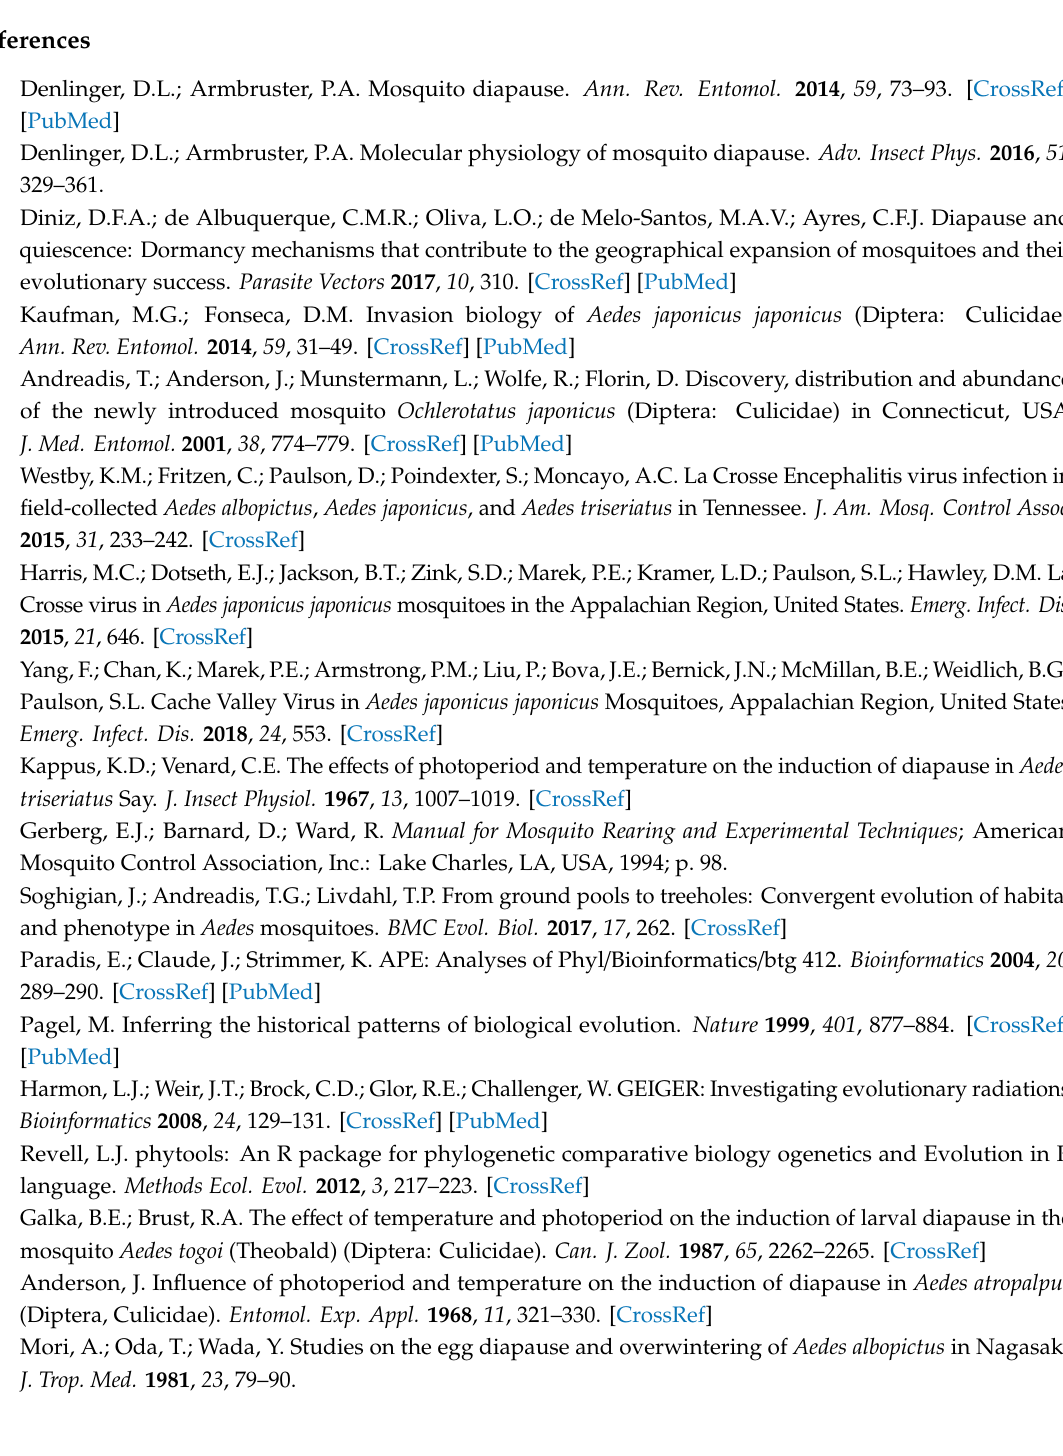
Table S1: Description of species, prediapause stage to induce embryonic diapause, and references; Figure S1: Posterior probabilities of nodes for Figure